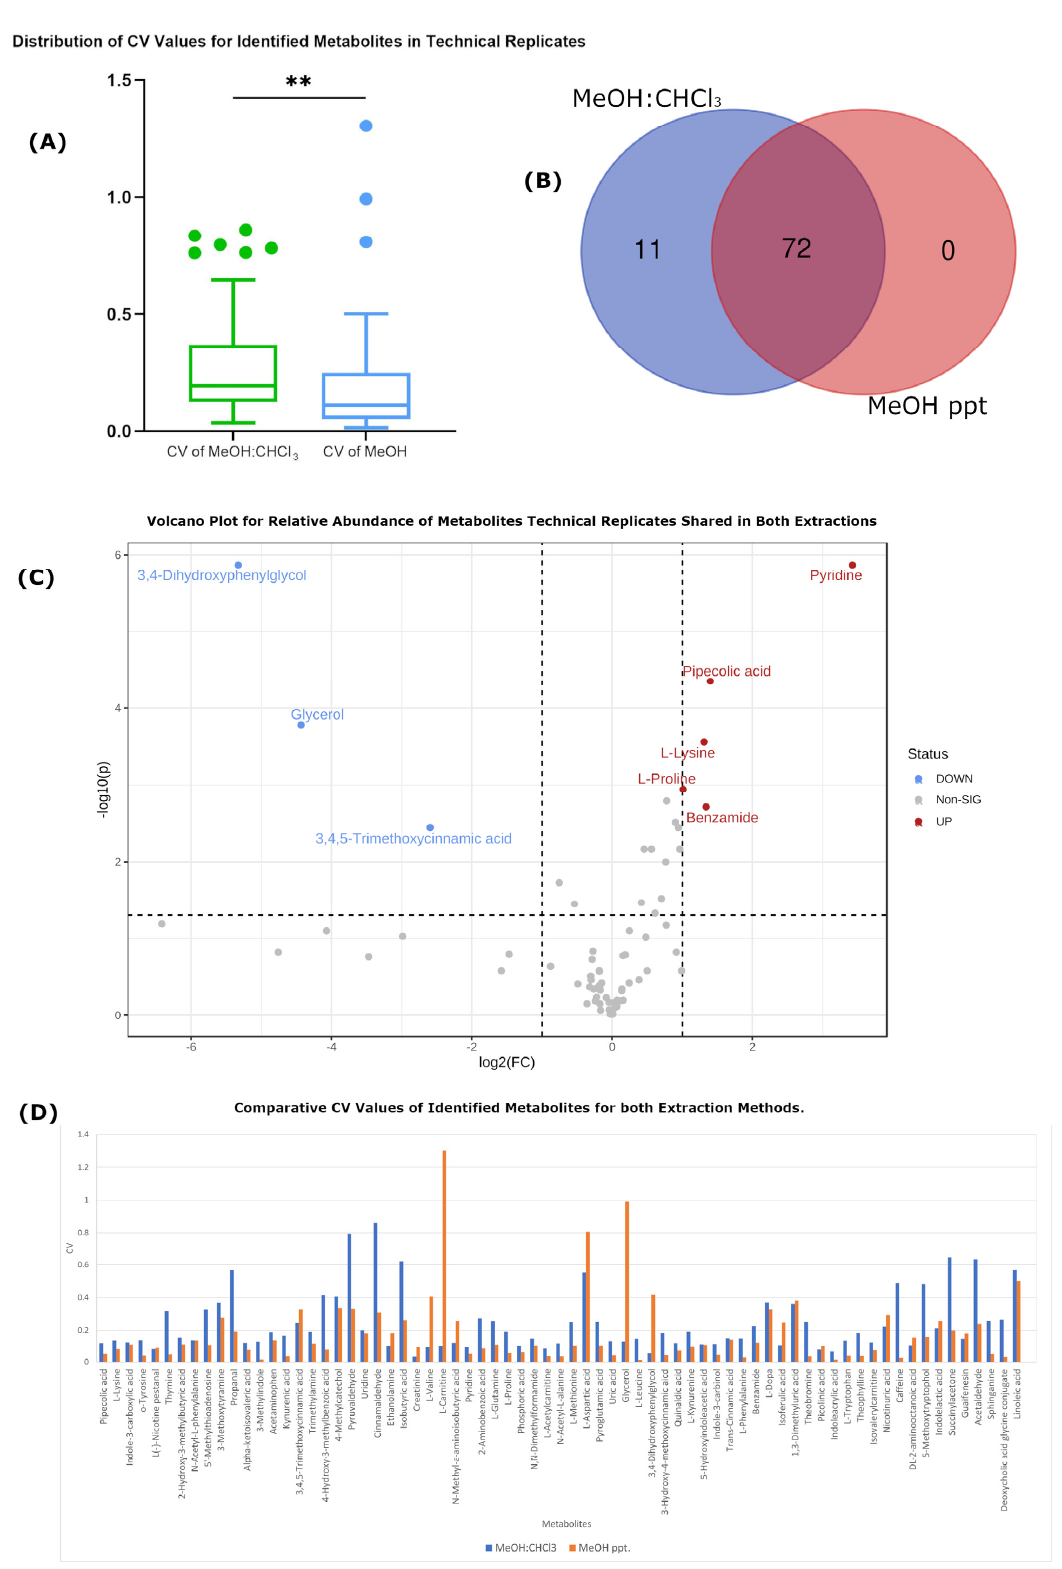
Figure 2. Representation of technical variation through different statistical analyses. ( A ) Box plot that shows the distribution of CV values for identified metabolites for both methods. Green color represents CV values of metabolite intensities in MeOH:CHCl 3 , while blue colour represents CV values of metabolites intensities in MeOH-only. ** indicates p ≤ 0.01 ( B ) Venn diagram for the